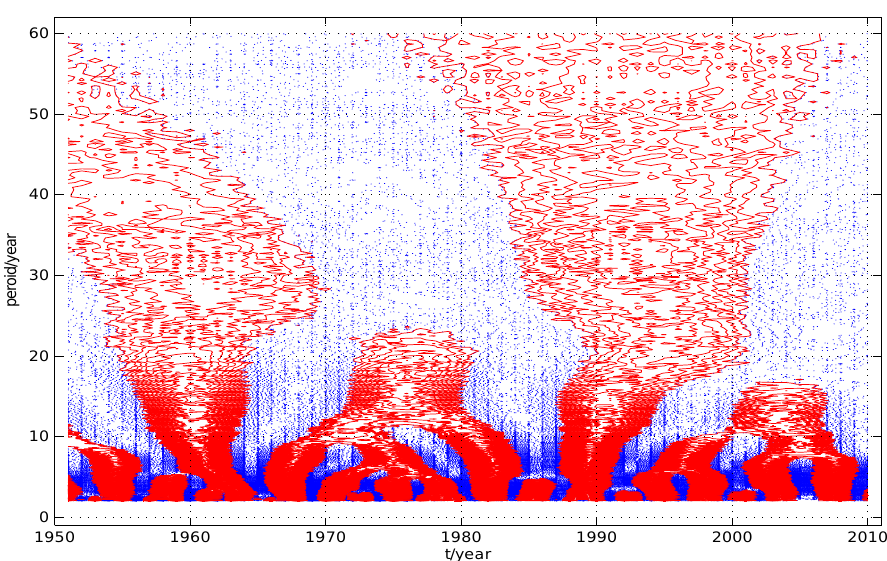
Figure 5. This contour is computed by using CWT function in wavelet toolbox of Matlab with the Morlet wavelet parameter σ 2 = 1, η = 5 for Data 2.